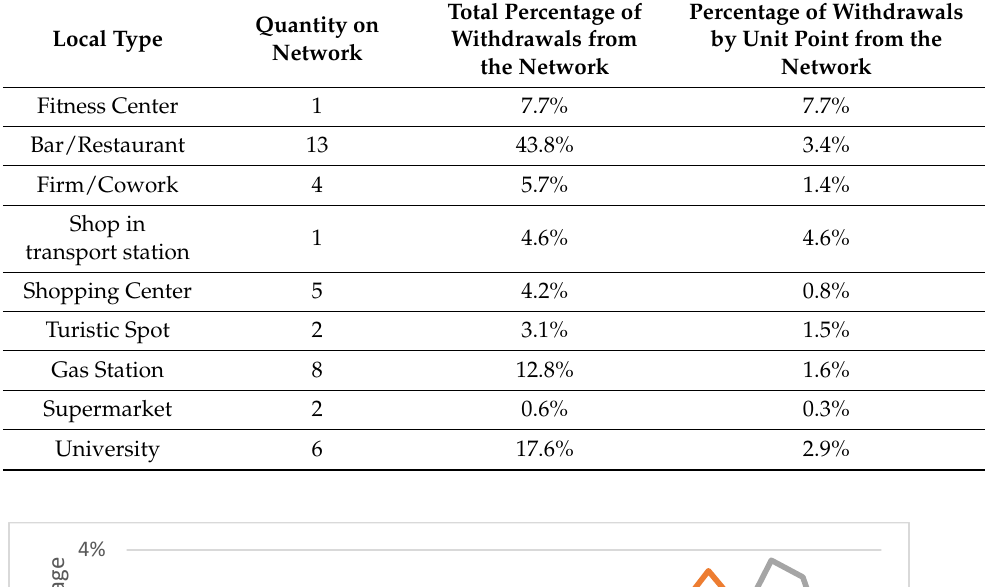
Table 8. Local types and percentage of withdrawals per locale.